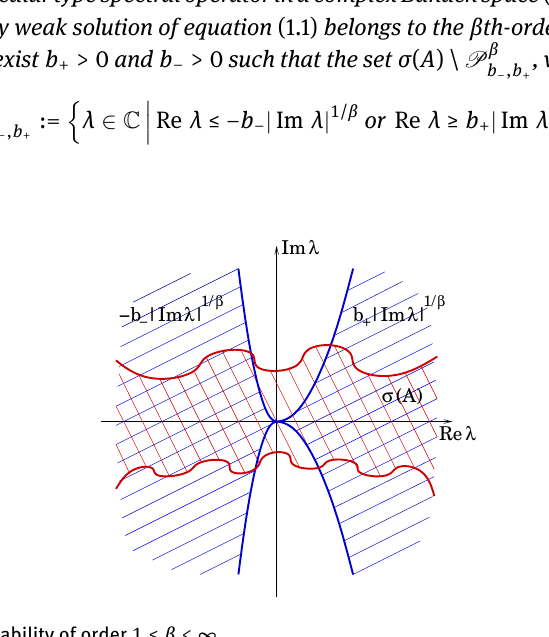
Figure 1: Gevrey ultradifferentiability of order 1 ≤ β < ∞